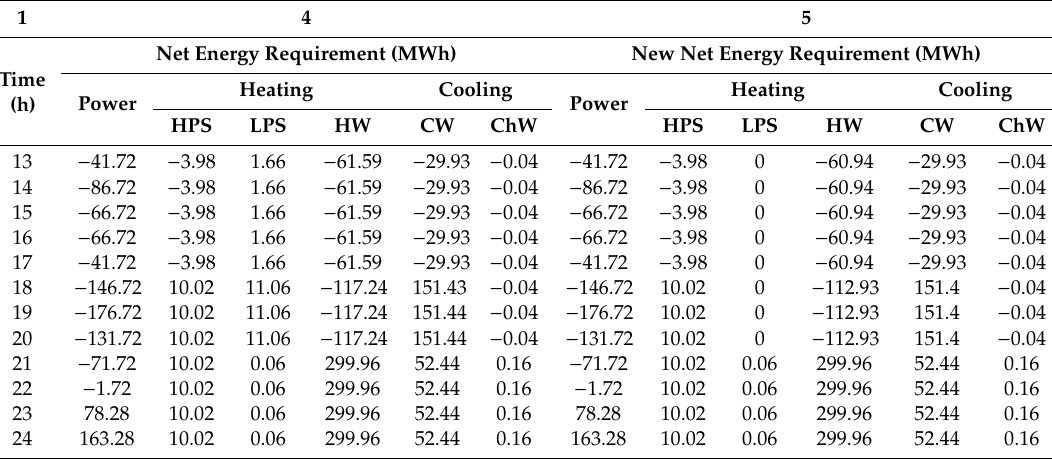
Table A22. TriGenSCA for final trigeneration PWR NPP without integration from time 13 to 24